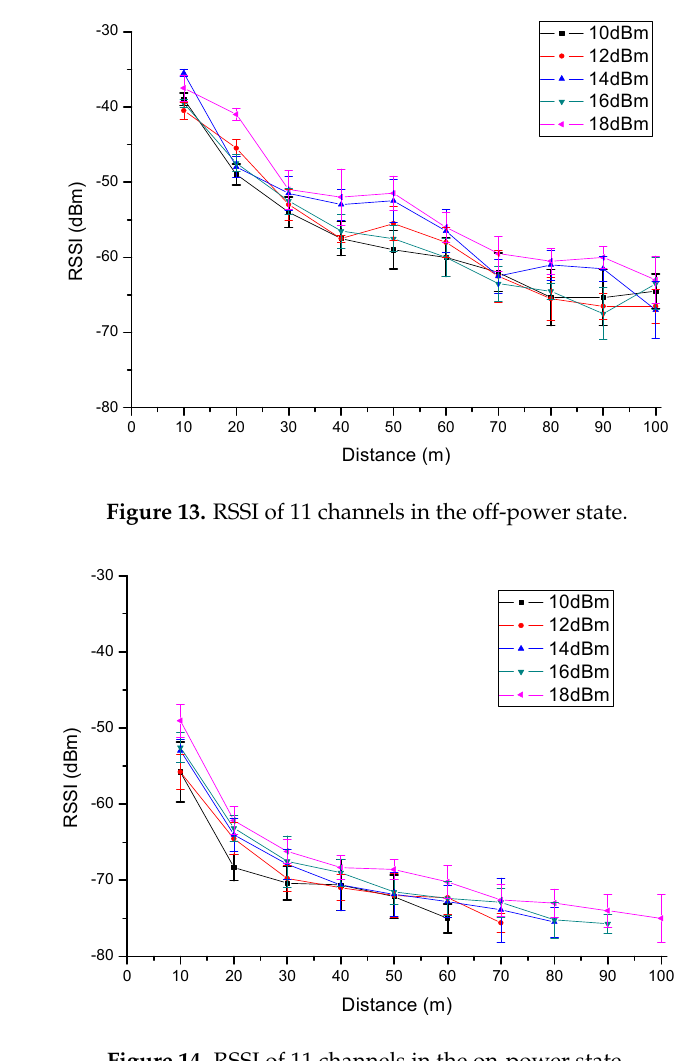
Figure 14. RSSI of 11 channels in the on-power state.